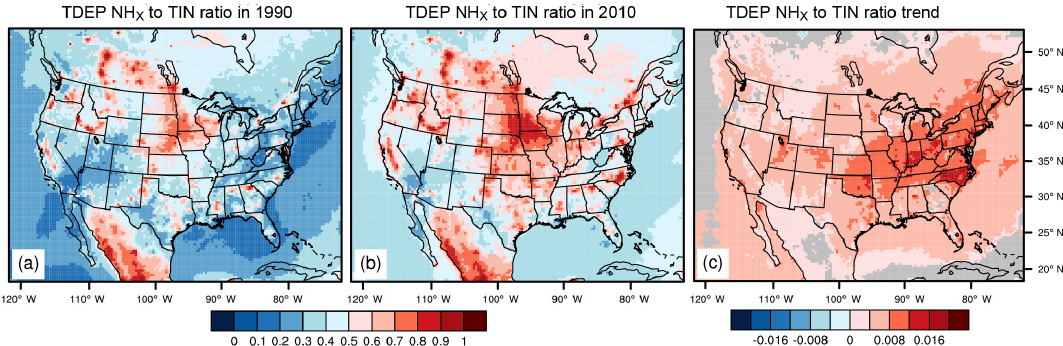
Figure 9. The ratio of TDEP of NH x over the TDEP of TIN in 1990 (a) , 2010 (b) , and the trend (c) . The blue color in panels (a, b) indicates a NH x ratio less than 0.5, which means TNO 3 dominates the total nitrogen deposition, while the red color indicates a ratio larger than 0.5 and NH x dominates the total nitrogen